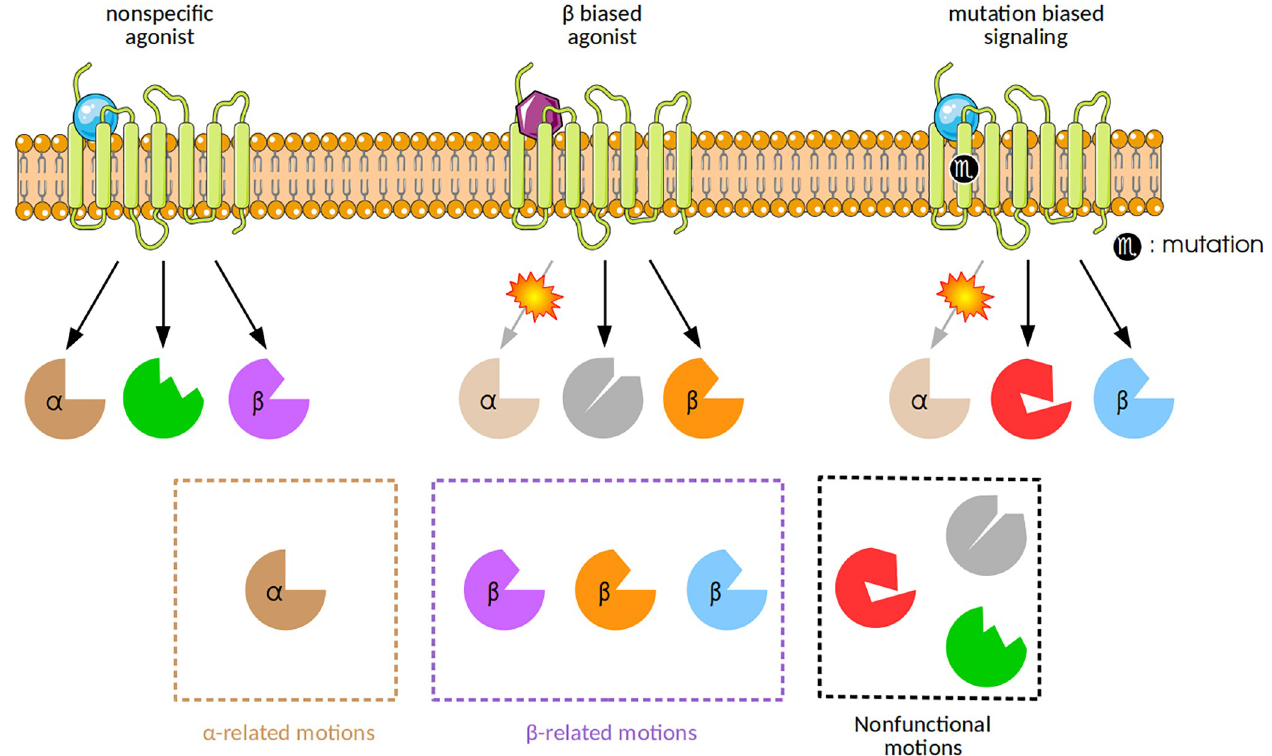
Fig 1. Multisignaling receptors and biased signaling. The binding of a nonspecific ligand (blue sphere) to a multisignaling receptor promotes a change in the receptor’s dynamics. This change results in motions that are linked to α and β signaling pathways (brown and purple shapes, respectively). On the other hand, a biased ligand (purple hexagon) is able to activate a singular signaling path ( β , orange shape). A mutation in the receptor can also result in biased signaling. In this figure, the interaction of a nonspecific ligand with the mutant receptor results in the activation of β signaling path (blue shapes), but not the α one. In addition, the presence of nonfunctional motions are observed in all